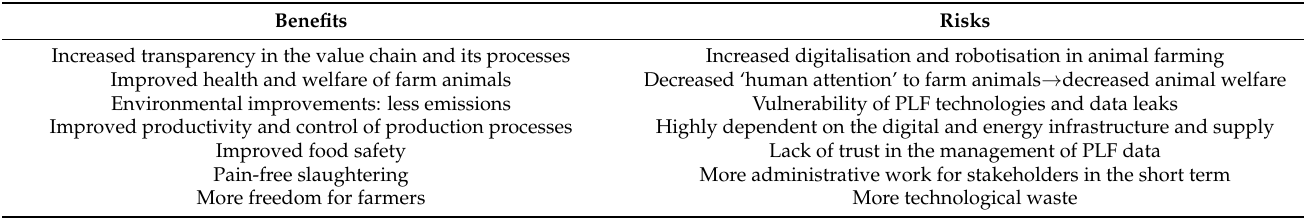
Table 2. Benefits and risks associated with the integration of PLF and the associated technologies, as identified by focus group